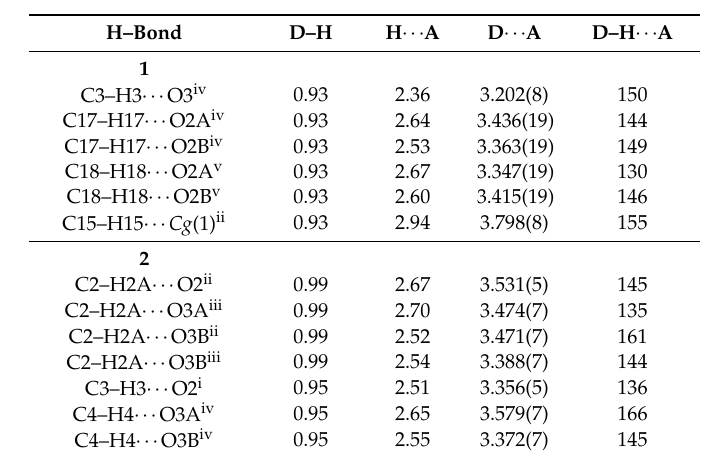
Table 4. Hydrogen bonding geometry (Å, °) for silver(I) complexes 1 and 2 .